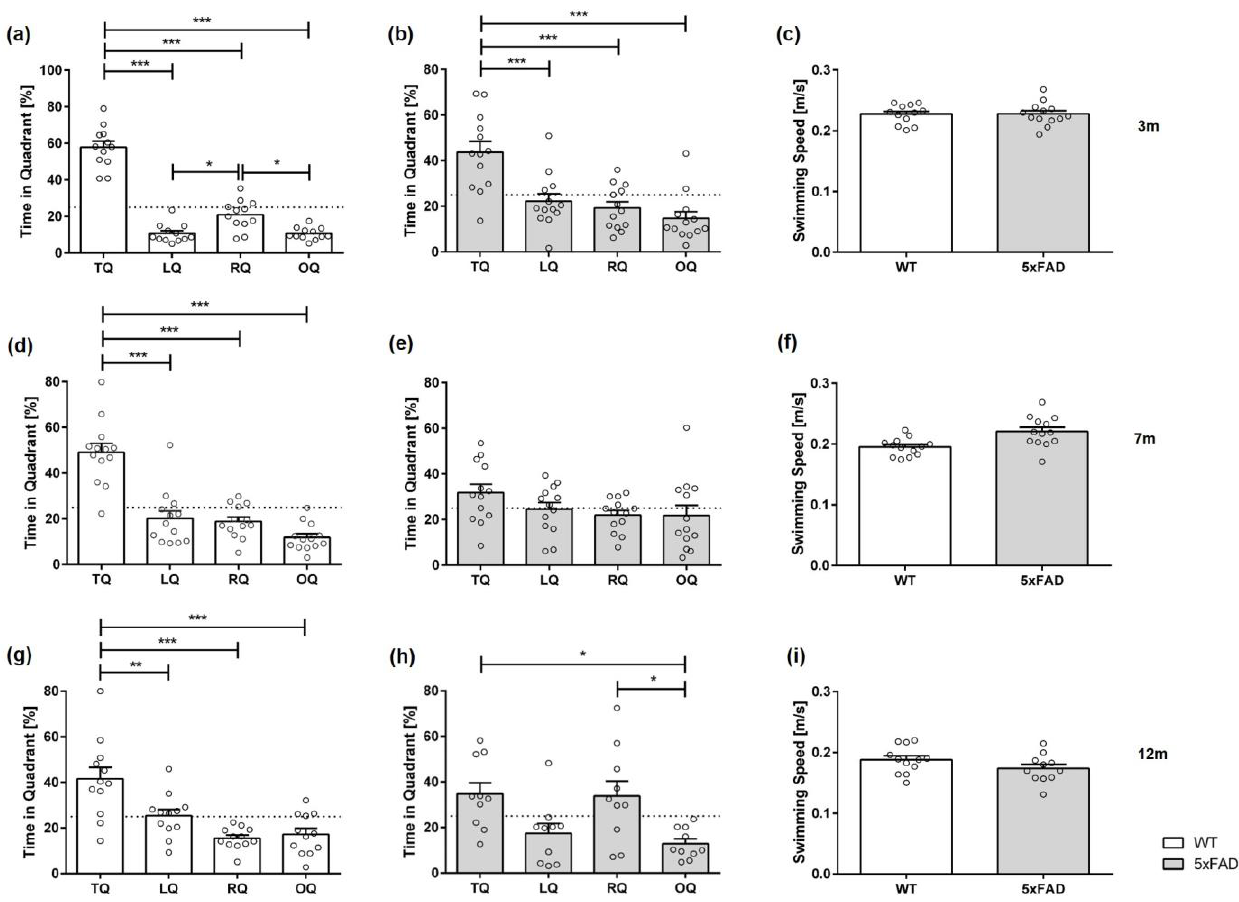
Figure 4. Female 5xFAD mice show age-dependent deficits in spatial reference memory in the probe trial. WT animals ( a , d , g ) and 3-month-old 5xFAD mice ( b ) showed a clear preference for the target quadrant during the probe trial. In contrast, 7- and 12-month-old 5xFAD mice demonstrated no clear preference for the target quadrant ( e , h ). Swimming speed did not vary between 5xFAD and WT mice ( c , f , i ). TQ = target quadrant, LQ = left quadrant, RQ = right quadrant, OQ = opposite quadrant. Data presented as mean ± S.E.M., n = 10 – 13. Quadrant preference: one-way repeated measures ANOVA followed by Bonferroni correction for multiple comparisons: * p < 0.05, ** p < 0.01, *** p < 0.001. Swimming speed: unpaired t -test.